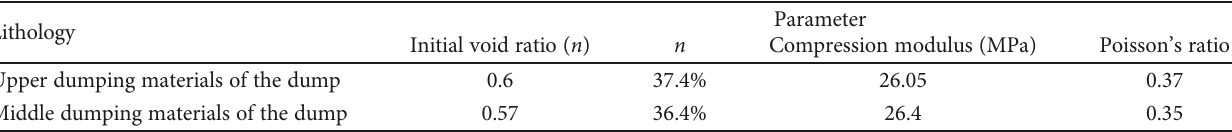
Table 2: Key deformation parameters of granular waste